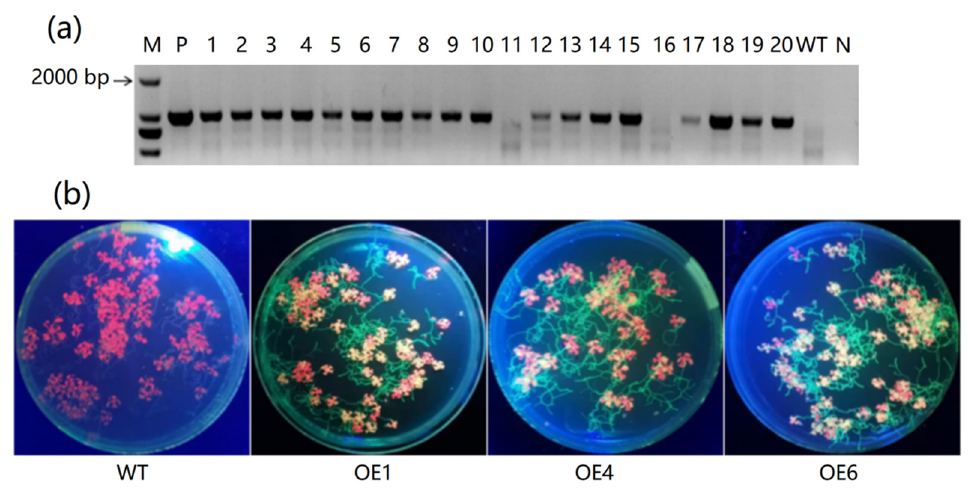
Figure 4. Detection of transgenic Arabidopsis heterologously expressing MeAnn2 . ( a ) PCR detection of the leaves of resistant transgenic Arabidopsis seedlings, T1 generation. M: DL2000; P: Positive plasmid control; 1–20: Transgenic Arabidopsis lines; WT: Columbia-0 Arabidopsis ; N: Negative control. ( b ) The fluorescent protein excitation light source irradiation results of some transgenic Arabidopsis